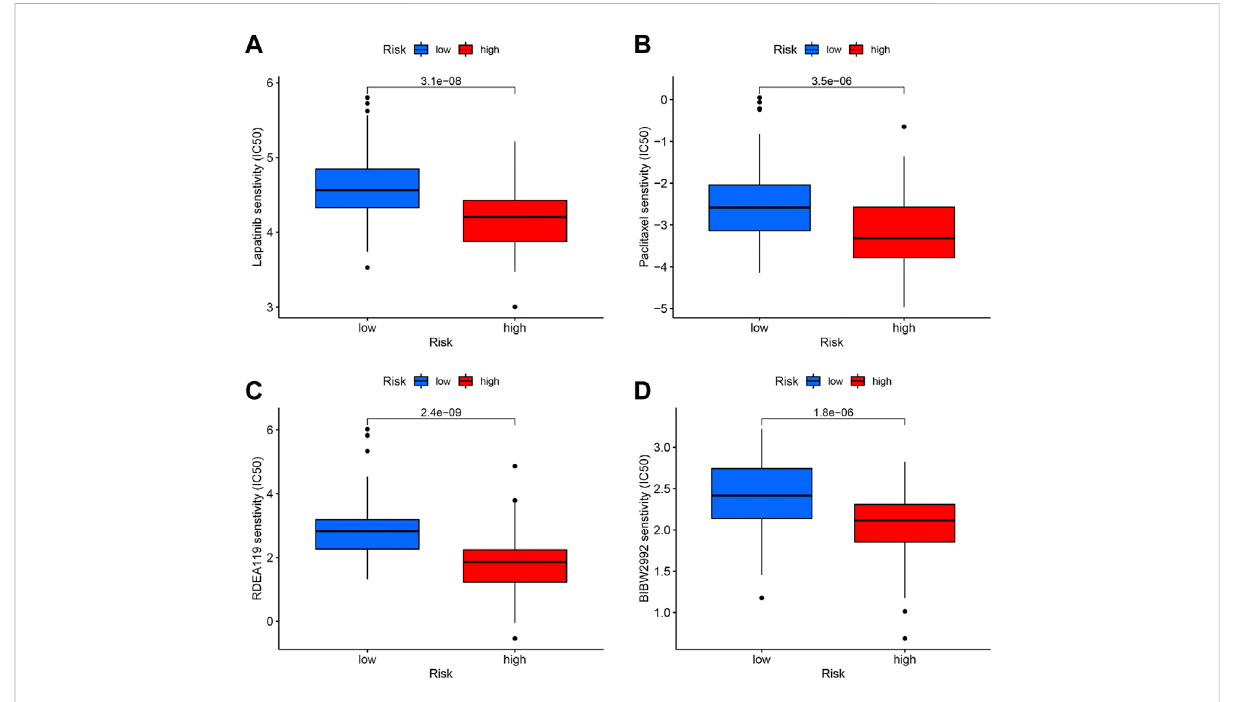
FIGURE 9 Drug sensitivity analysis. The candidates are Lapatinib (A) , Paclitaxel (B) , Refametinib (C) , and Afatinib (D)